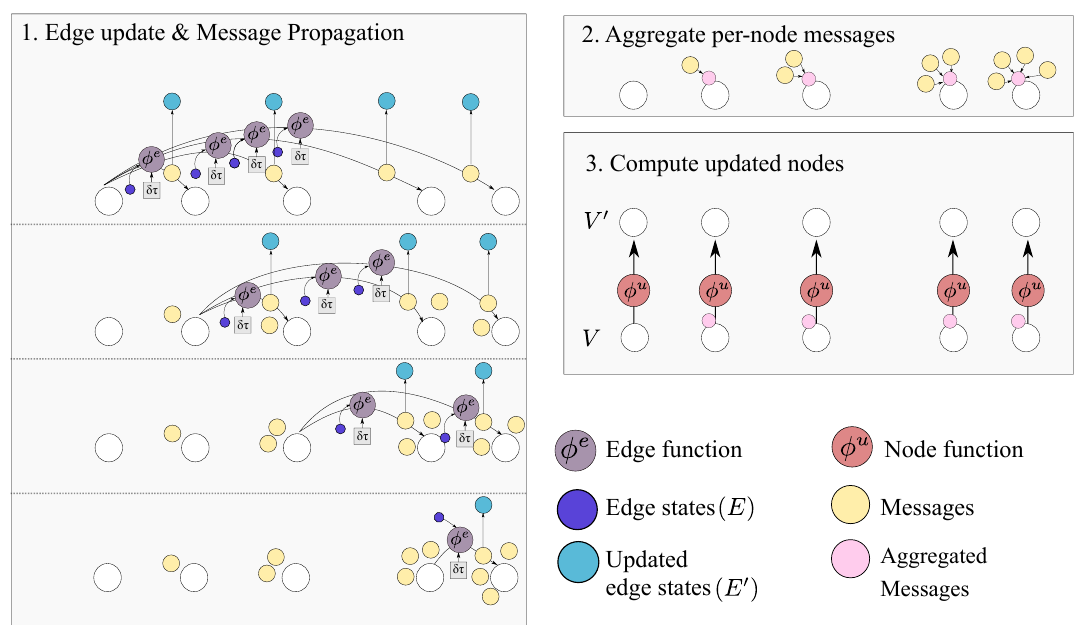
Figure 7. The Causal GN computation step. As detailed in Algorithm 1 the procedure can be summarized in edge update, aggregation and node update steps. The output graph contains E (cid:48) and V (cid:48) . Several steps of this computation can be applied.